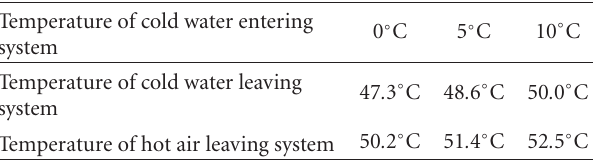
Table 6: Outlet fluid temperatures at varying inlet temperatures. Table 7: Solar thermal domestic hot water supply system specifica-